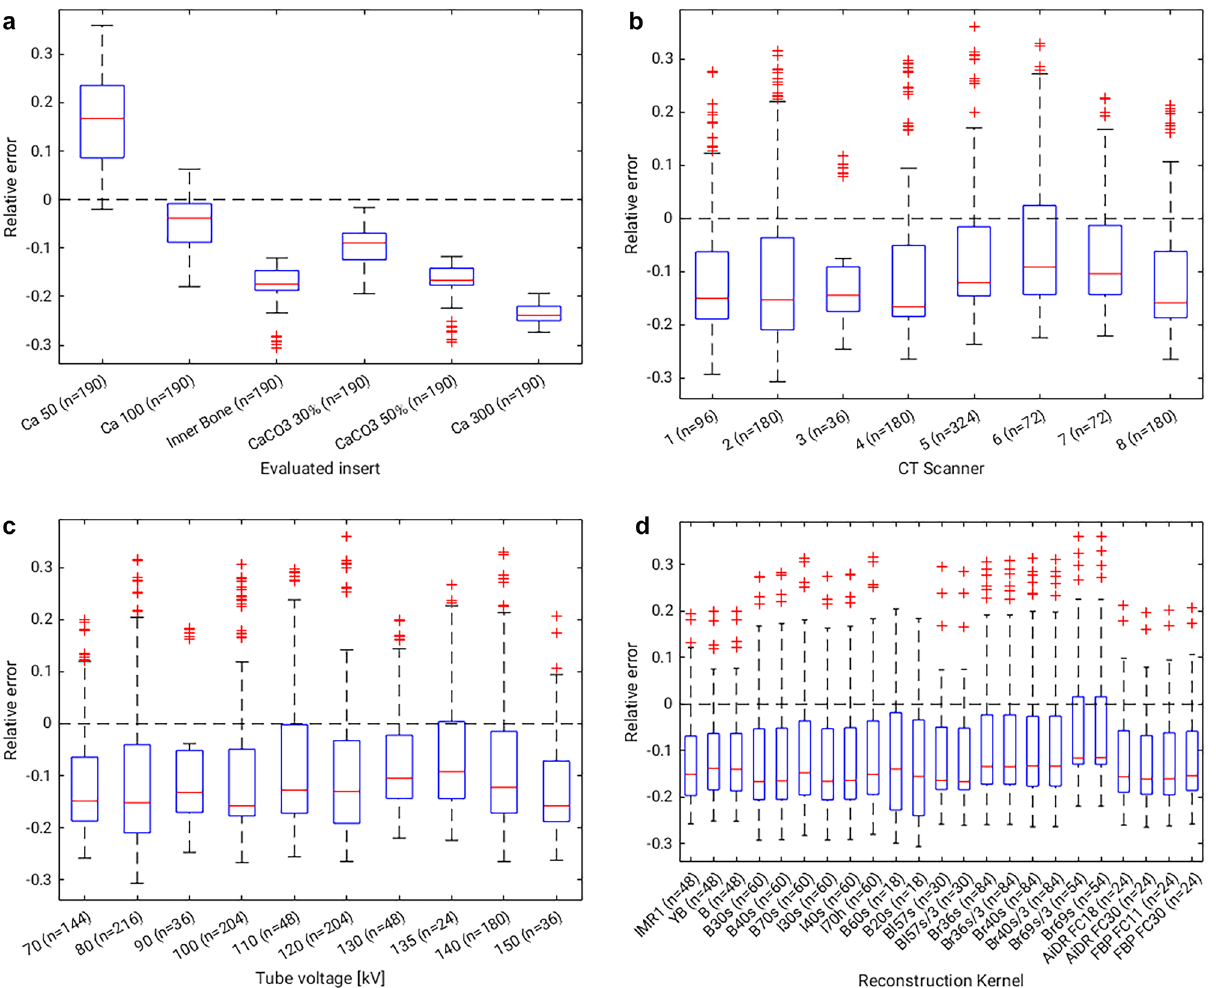
Figure 2. Relative error of computed bone mineral density compared to the calculated ground truth values over the different investigated parameters: ( A ) phantom insert ( B ) CT scanner ( C ) tube voltage (D) reconstruction setting. Note the differences in sample sizes for the different parameters (also Table